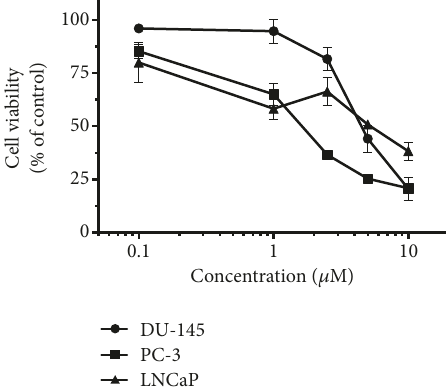
Figure7: Relativetoxicitiesof4,5-diCQAonDU-145,LNCaPandPC-3prostatecancercells .Experimentswereperformedbyseeding5000/cells per well in 96-well tissue culture plate. After 24 hours, the culture medium was replaced with media containing 4,5-diCQA for treatment samples. Concentrations of 0.1 𝜇 M, 1.0 𝜇 M, 2.5 𝜇 M, 5.0 𝜇 M, and 10.0 𝜇 M of 4,5-diCQA were used along with cultures with no treatments (control). After incubation for 72 hours, CCK-8 assay was performed by adding 10% CCK-8 solution in medium followed by incubation at 37 ∘ C after which absorbance was measured at 450 nm. Absorbances were normalized to untreated controls to determine cell viability. Mean ± standard deviation of triplicates is represented.